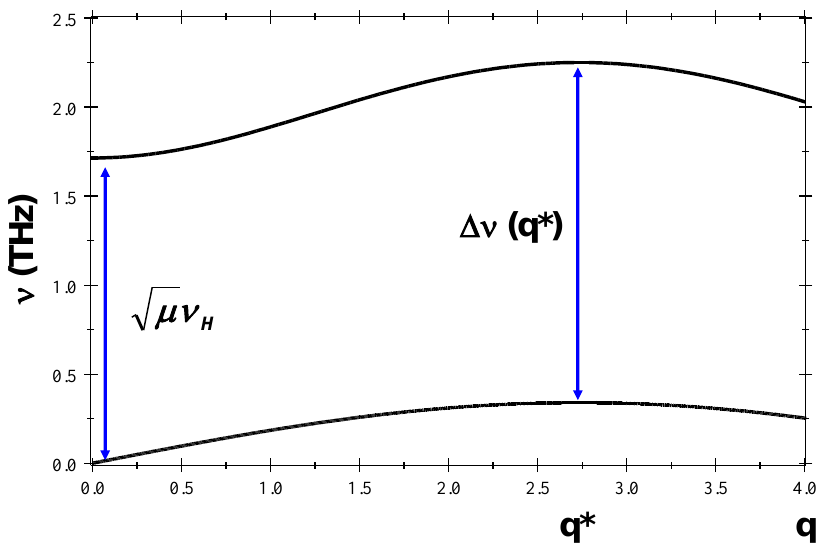
Figure 4. Acoustic and optical phonon branches for polyG-polyC and polyA-polyT dsDNA homopolymers (their ν ( q ) and ν + ( q ) curves respectively coincide up to the third decimal place), where q is measured in nm − 1 . We have used the characteristic and coupled frequency values listed in Table 2.